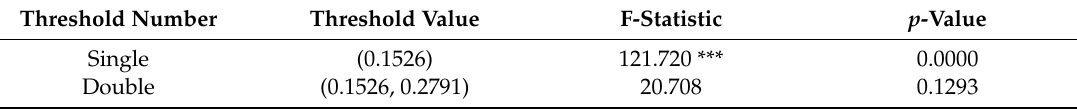
Table 4. Estimation and test of threshold value of firm performance